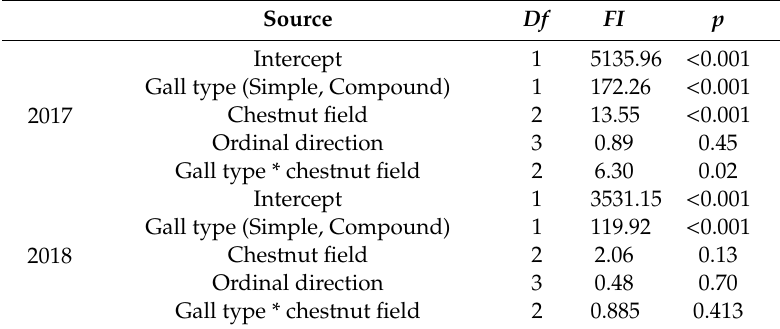
Table 1. Analysis of variance (ANOVA) evaluating the e ff ect of di ff erent variables and their interaction on the number of chambers in galls (Levene’s test; 2017: F = 1.19; df = 23, 405; p = 0.25; 2018: F = 1.12; df = 23, 404; p =